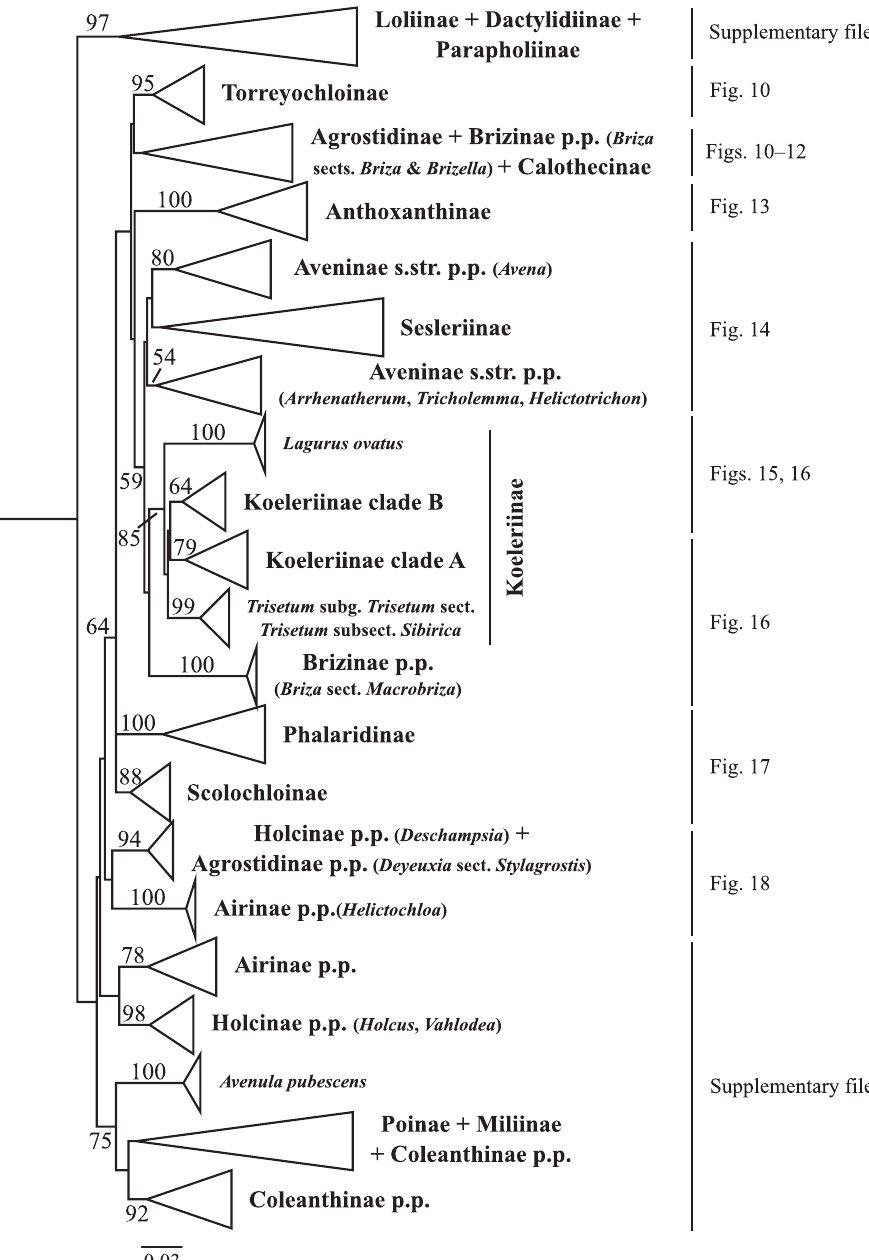
Figure 2. Overview of the maximum likelihood phylogram inferred from ITS data. Major clades in the complete tree are collapsed. The corresponding figures showing details of subsections of the tree are indi- cated. ML bootstrap support is recorded along branches. No support is shown for branches with bootstrap support <50%. The ML tree is presented in its entirety in Suppl. material